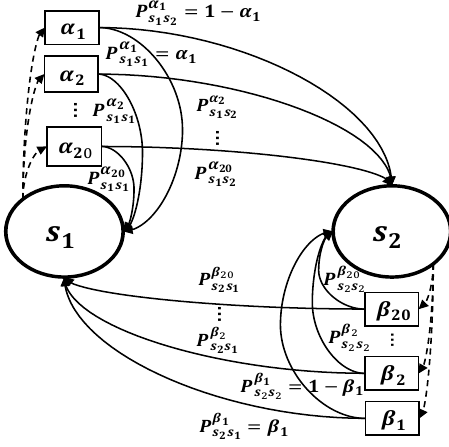
Figure 3. A two-state Markov decision process.